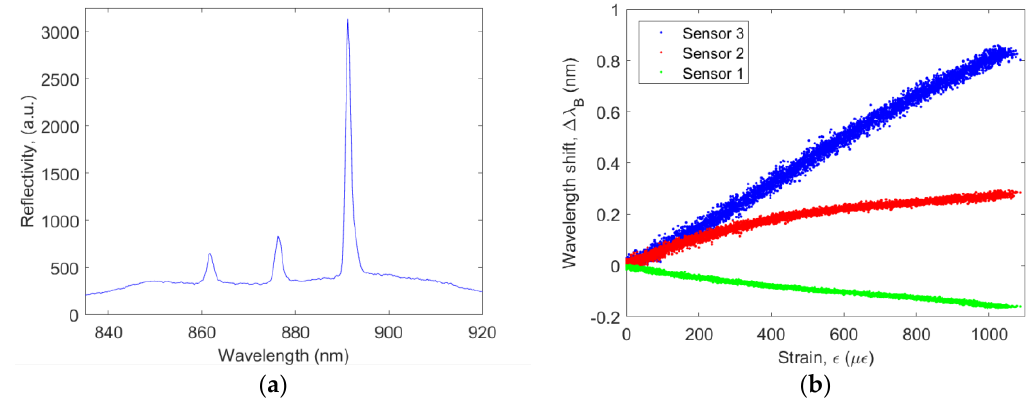
Figure 9. ( a ) Typical reflection spectrum recorded by the readout system. ( b ) Resulting Bragg wavelength as a function of applied strain.